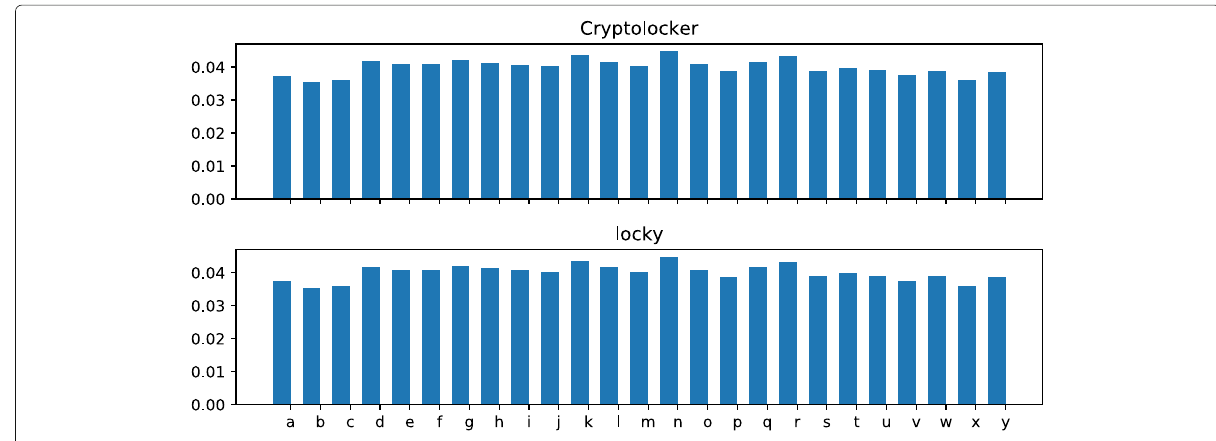
Fig. 4 Unigram distributions for Cryptolocker and